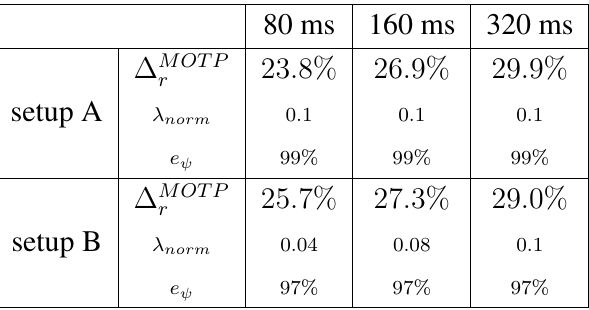
Table 7. Relative improvements of MOT P ( m ) for sequence seq03 , using the optimal parameter values estimated for sequence seq01